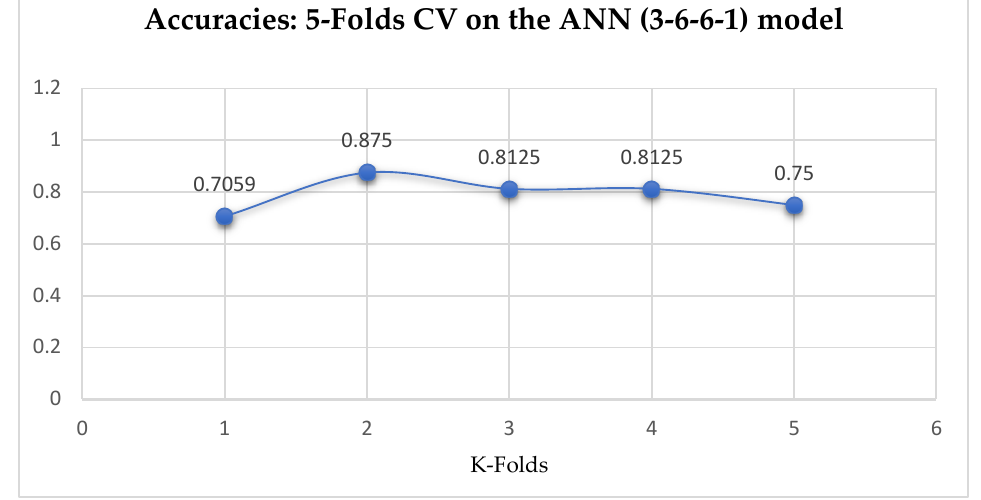
Figure 33. The accuracies achieved by the Folds after performing 5-Fold Cross-Validation on the ANN (3-6-6-1) model.